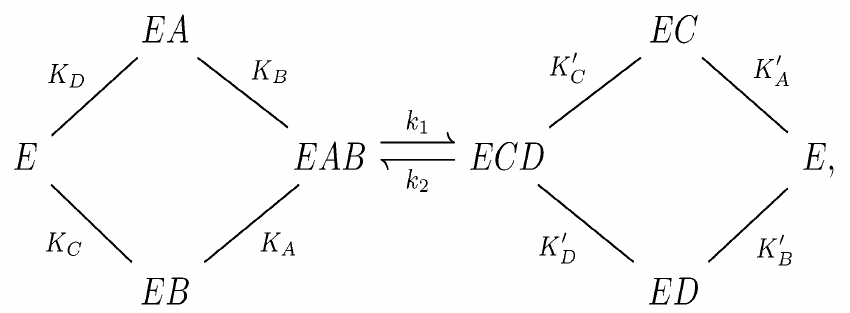
Figure 2. The Bi Bi mechanism for hexokinase I . Here, E , A , B , C , and D represent the hexokinase enzyme, ATP , glucose, ADP , and G 6 P , respectively. K X and K (cid:48) X = A , B , C , D